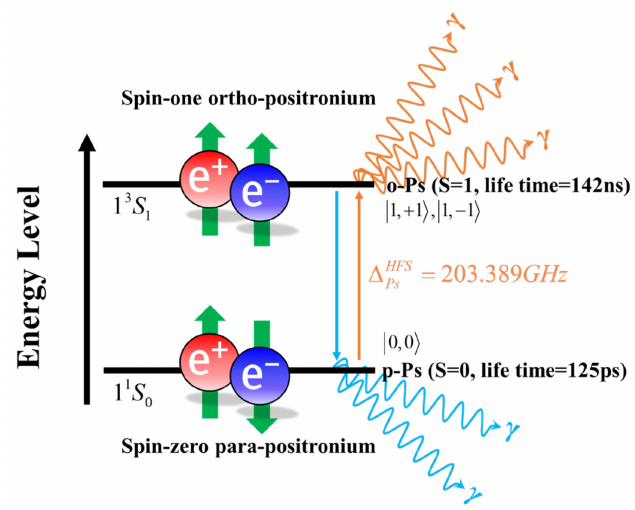
Figure 3. The hyper-fine split of positronium